Question: What does this figure show? Answer in one sentence.
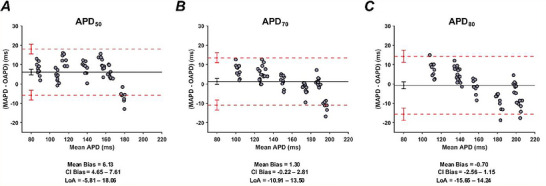
Answer: Bland–Altman analysis of agreement between monophasic action potentials (MAPs) and motion‐corrected optical action potentials (OAPs) for APD 50 , APD 70 and APD 80 under the combined motion tracking and ratiometry condition Bland–Altman analyses were performed using measurements obtained from seven hearts ( N = 7). Differences are plotted as MAP − OAP. The mean bias is shown as a solid black line, with its 95% confidence interval (CI) indicated by black error bars. The upper and lower limits of agreement (LoA) are shown as dashed red lines, with their corresponding 95% confidence intervals indicated by red error bars. A – C , Bland–Altman plots for APD 50 , APD 70 and APD 80 , respectively. C , expanded view of the APD 80 Bland–Altman plot; the same analysis is shown with a common axis scale across correction methods in Fig. 6 Ad .